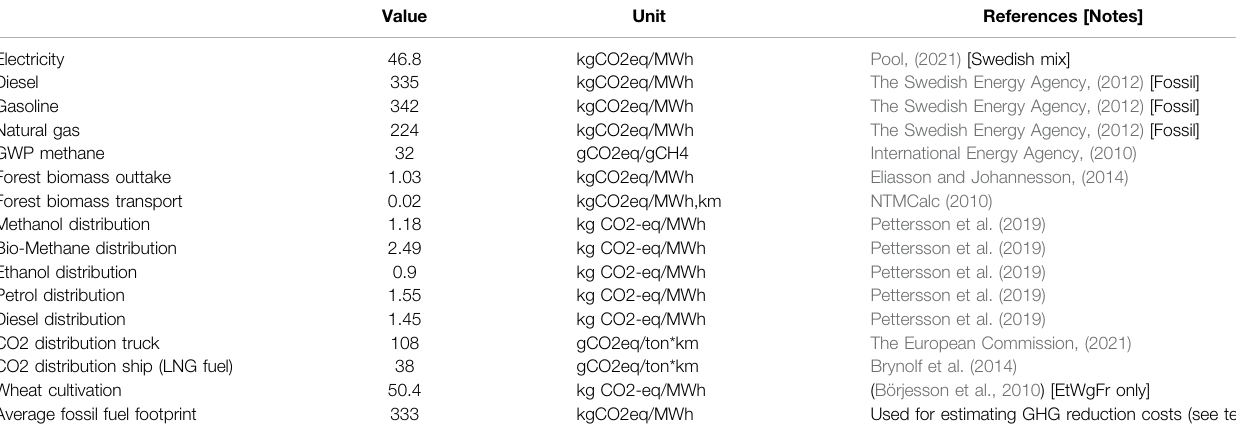
TABLE 4 | Overview of the most important emission